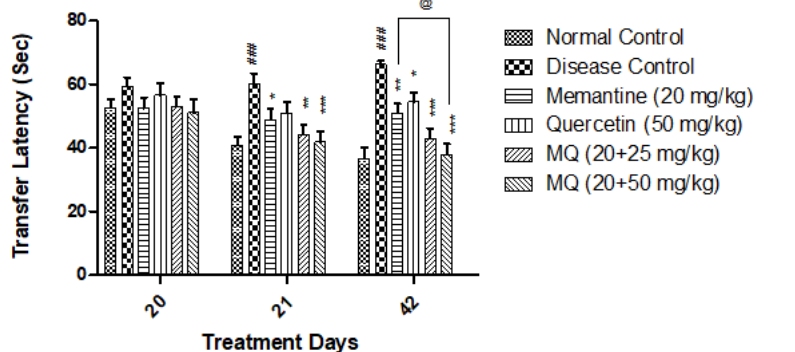
Figure 3. Effect of quercetin and quercetin with memantine on transfer latency in AlCl 3 -induced neurotoxicity in rats. Data are expressed as mean ± SEM ( n = 6), ### p < 0.001 when compared with the normal control group, * p < 0.05, ** p < 0.01, *** p < 0.001 when compared with the disease control group, and @ p < 0.05 when compared with the memantine treatment group. AlCl 3 : aluminum chloride; SEM: standard error of mean.